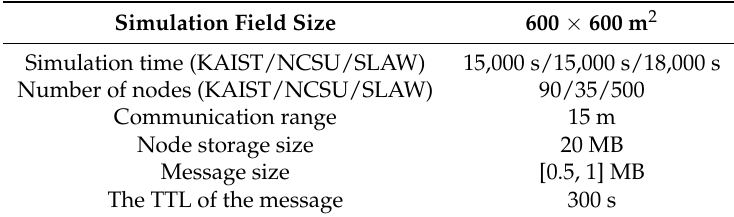
Table 1. Simulation